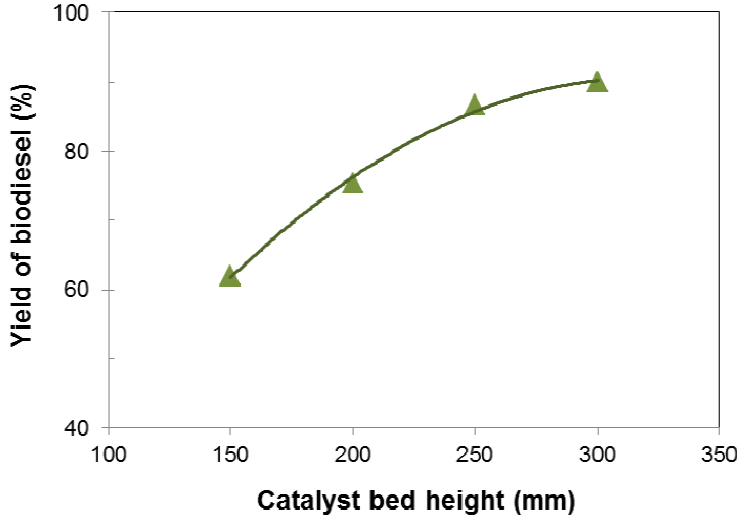
Figure 7. Effect of catalyst bed height on the yield of biodiesel in